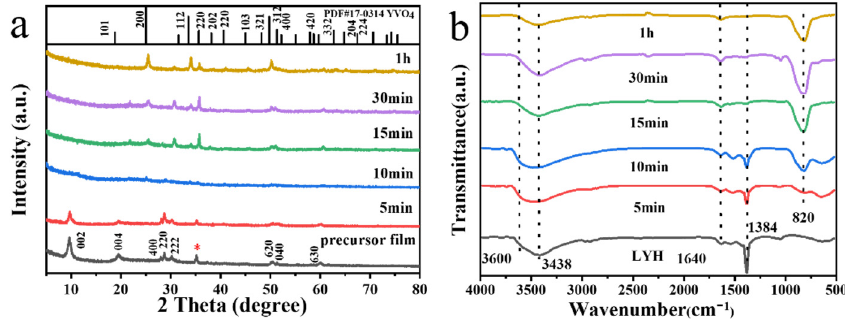
Figure 3. XRD patterns ( a ) and FT-IR spectra ( b ) of anion exchange films prepared with different reaction time. The diffraction peaks of ITO glass were marked with *.